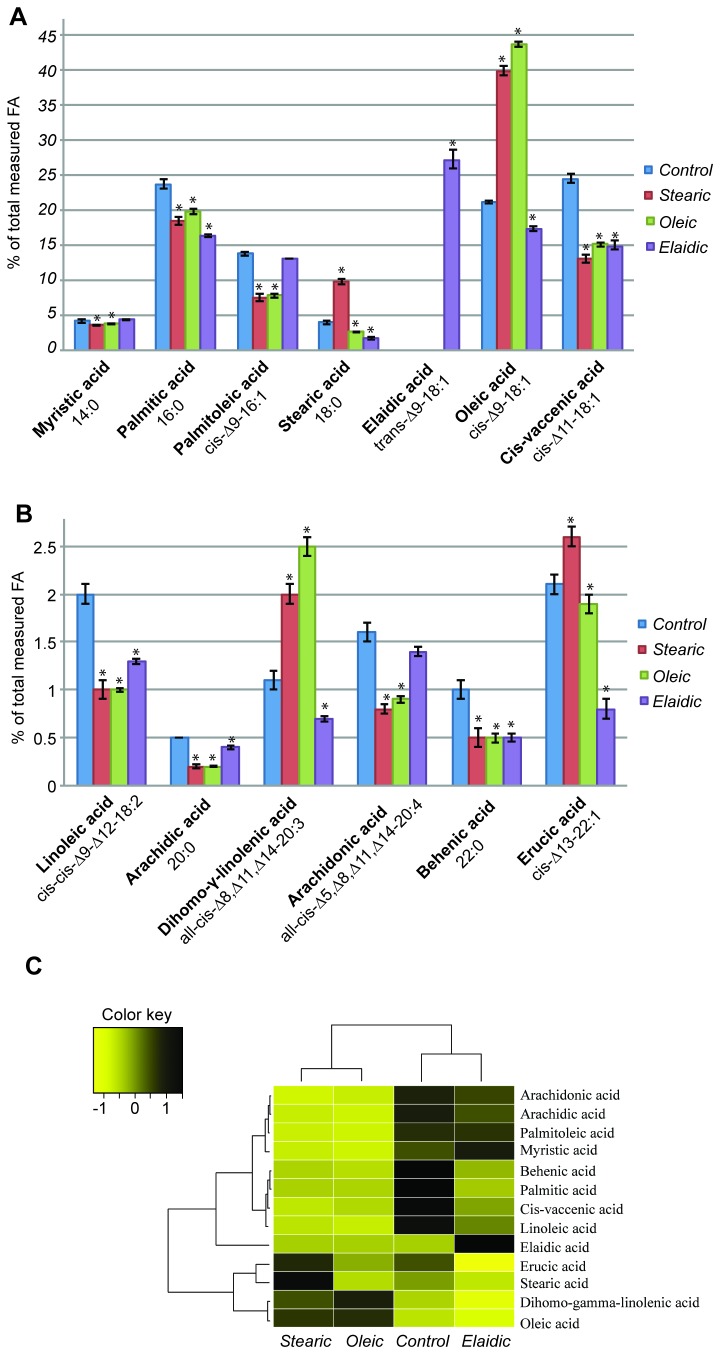
The FA composition of HepG2-SF phospholipids analyzed by gas chromatography.The composition of phospholipids from HepG2-SF cells incubated 6 days in 100 µM oleic, elaidic, or stearic acid supplemented medium were determined. Panel A and Panel B are the high and low abundant FAs present in the PLs, respectively. Each bar represents the average of three biological replicas. The y-axis is the percent of total FA methyl esters measured. The x-axis indicates the different PL FAs measured as their methyl esters. Color coding corresponds to the different supplemented FFAs. Panel C shows a heatmap representation of the distribution of FAs in PLs of the HepG2-SF cells after supplementation. The FA composition of HepG2-SF phospholipids change depending on the different supplemented fatty acids, Stearic and Oleic profiles are alike whereas the Elaidic FA PL profile differs from all the other groups. * marks measurements significantly differing from controls using the unpaired t-test, two-tailed with a 95% confidence interval.